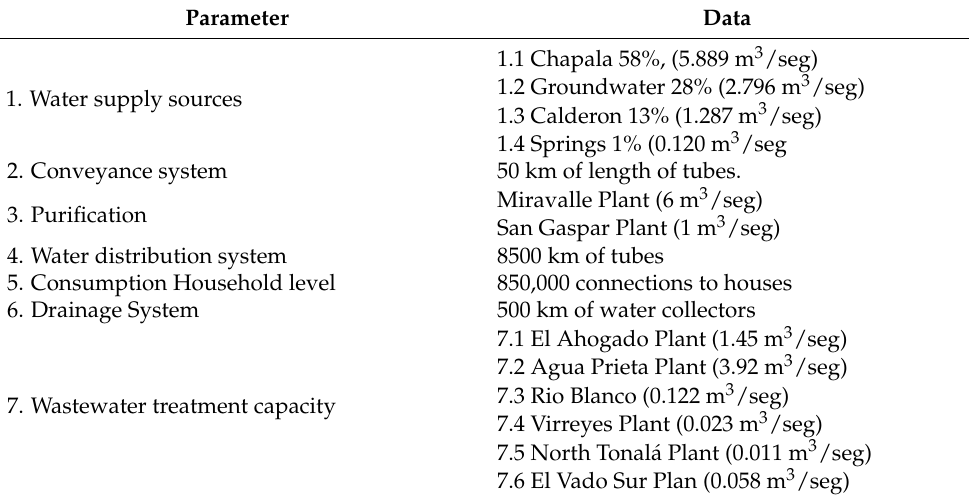
Table 1. Data of each phase of water utilities